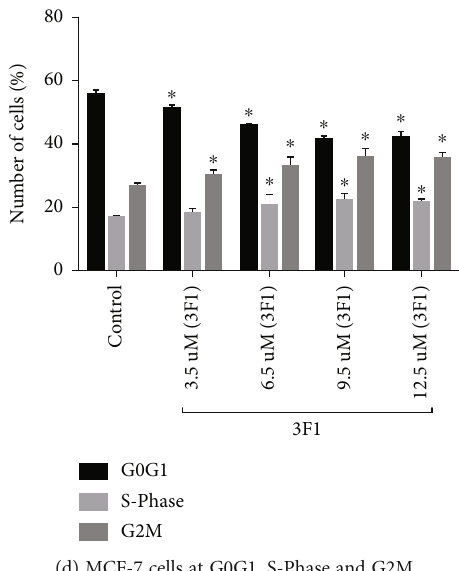
Figure 7: Percentage of cells at G0G1, S, and G2M phase. MDA-MB-231 (a, c) and MCF-7 (b, d) cells were treated with the indicated doses of compound 3F1 for 24h. Cells in the negative control samples were treated with 0.1% DMSO. The cells were then fi xed with ice-cold 70% ethanol and stained with propidium iodide (PI) from the MUSE cell cycle kit for MUSE fl ow cytometry analyses. S and G2/M phase cell population was consistently high while G0G1 cell population was consistently low in the treated breast cancer cells compared to those of nontreated cells. Data are presented as the mean ± SD of three independent